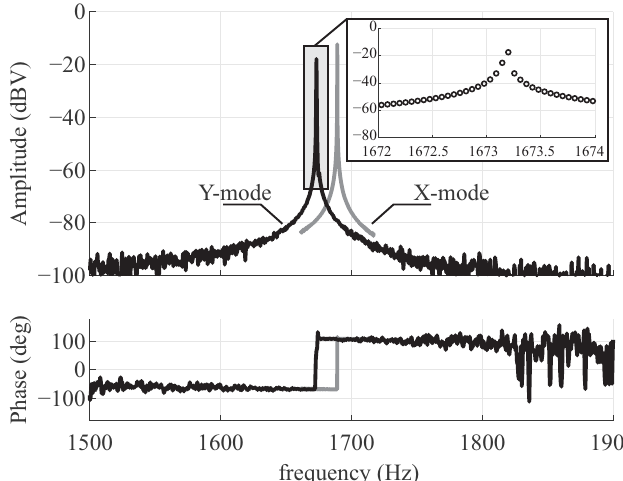
Figure 6. Experimental results of the anti-phase drive (X-mode) and the sense (Y-mode) frequency responses. Illustrating the increase in amplitude spectral density near the resonance frequency of the modes.